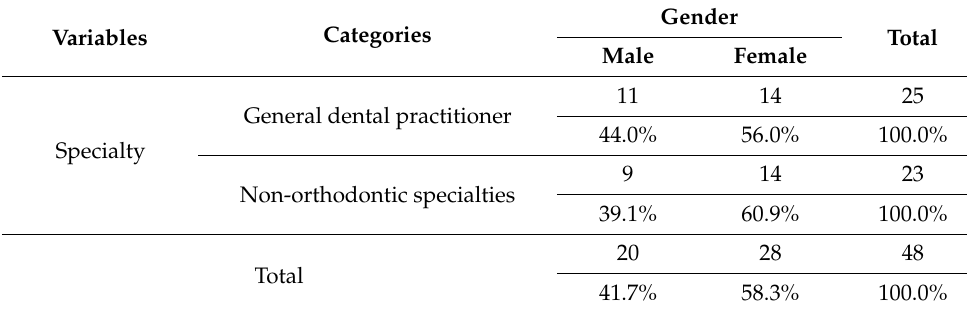
Table 3. Comparison between gender and specialty ( n =